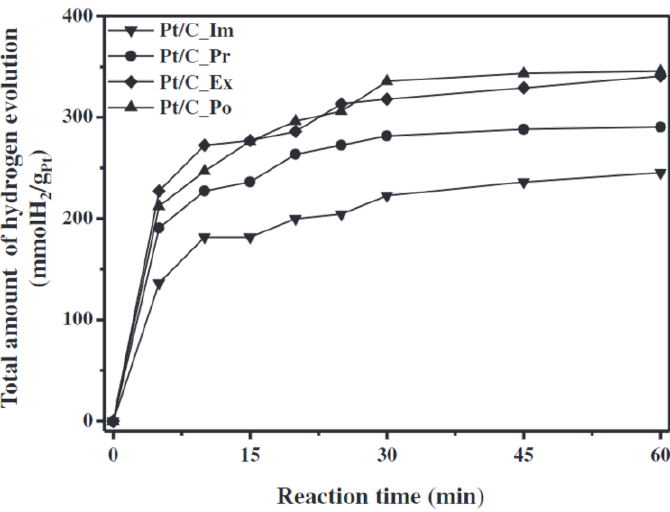
Figure 4. Catalytic performance of carbon-supported platinum catalysts (Pt / C_Im, Pt / C_Pr, Pt / C_Ex, and Pt / C_Po) over time on stream in decalin dehydrogenation. Reprinted with permission from [80].